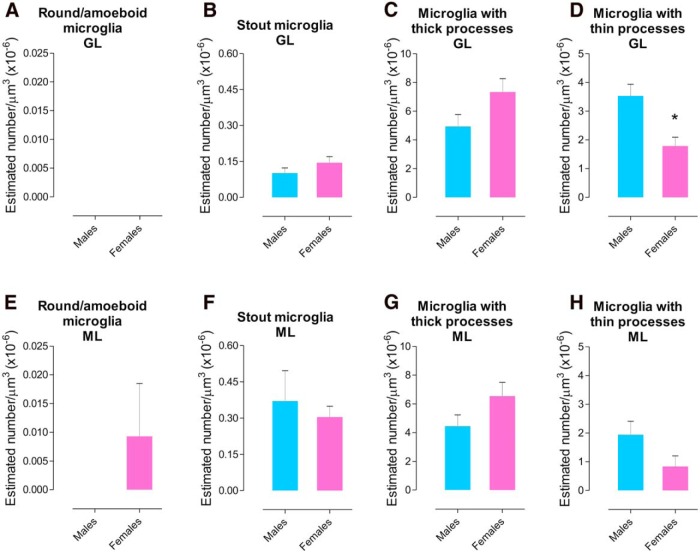
Microglial sex differences in the developing cerebellum. A–D, Estimated density of microglia based on morphology in the GL at P17. Males had more microglia with thin processes than females (*p = 0.026). No significant differences were found for sex in round/amoeboid microglia, stout microglia (p = 0.270) or microglia with thick processes (p = 0.127). E–H, Estimated density of microglia based on morphology in the ML at P17. The statistical analysis indicated no sex differences in round/amoeboid (p = 0.375), stout (p = 0.646), microglia with thick processes (p = 0.168), or microglia with thin processes (p = 0.137). Data are expressed as mean ± SEM (n = 6, 3 males + 3 females for each group).